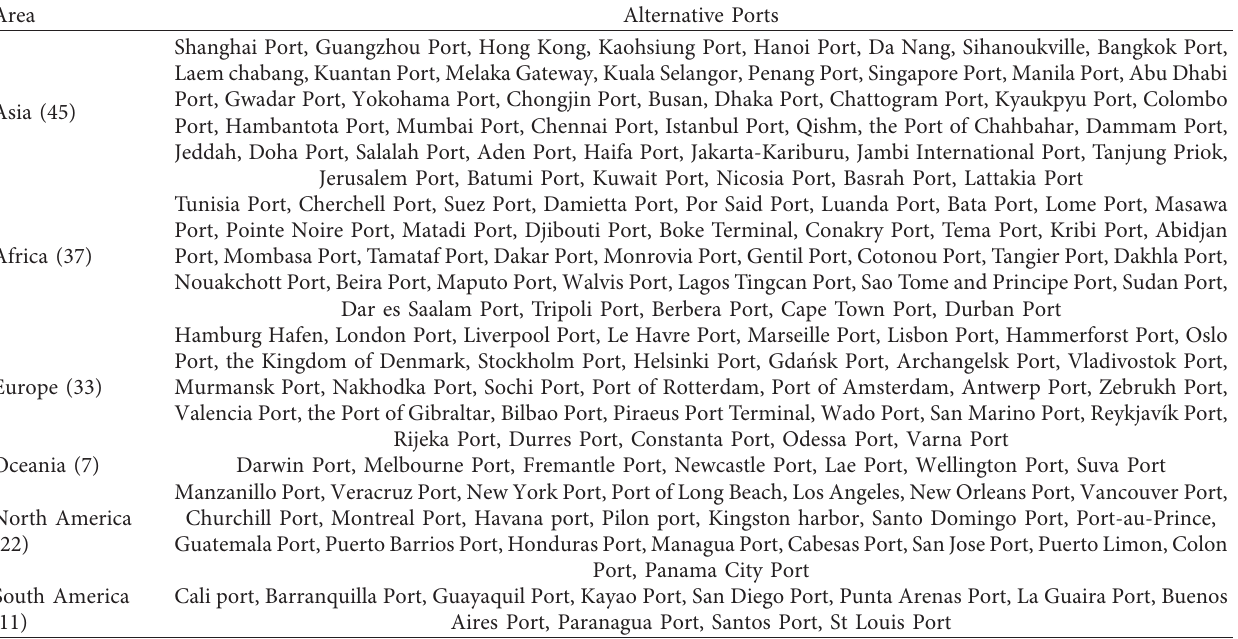
Table 1: List of alternative port